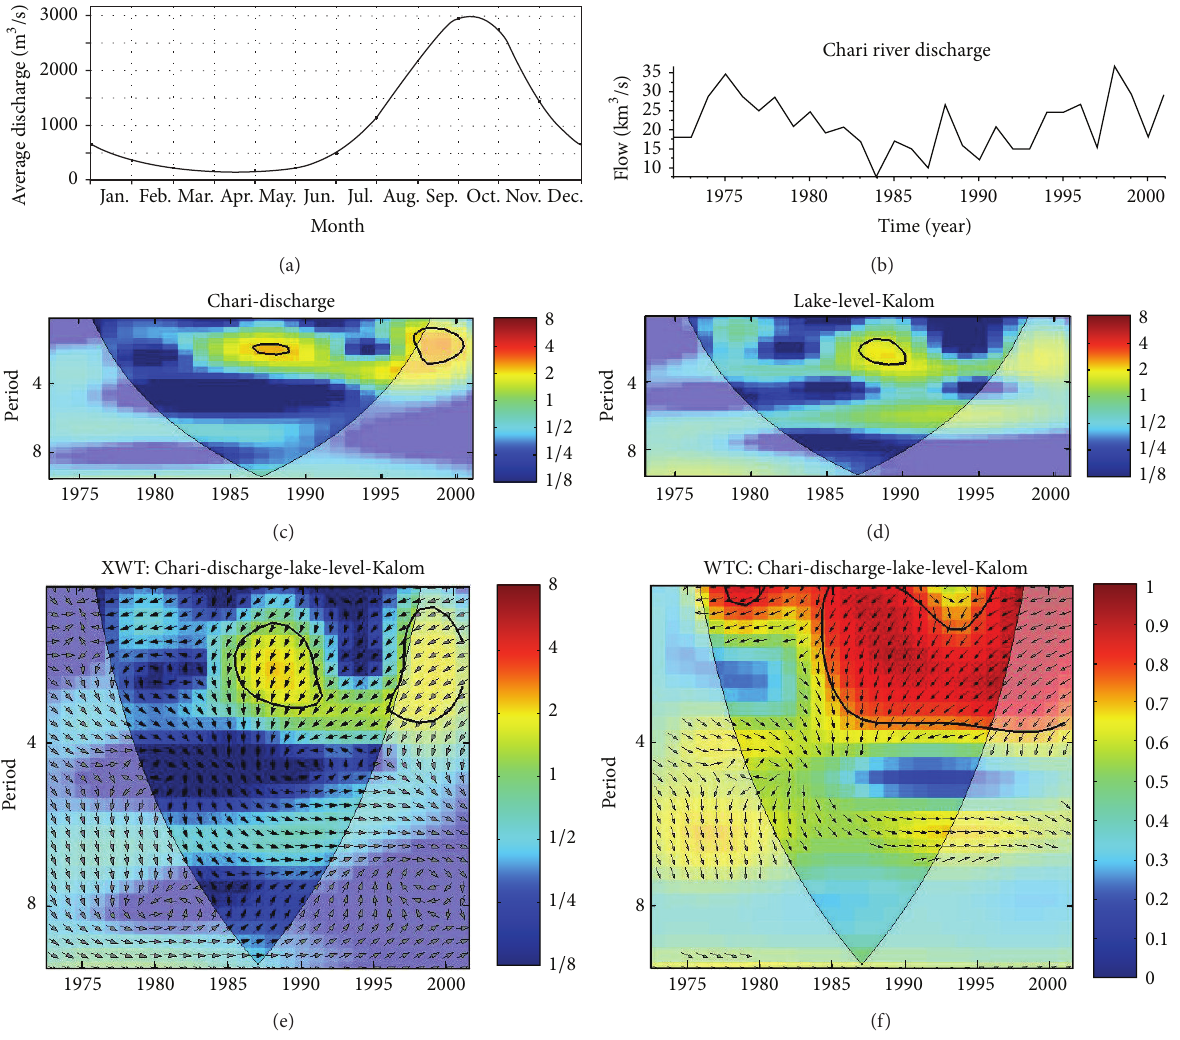
Figure 8: Chari River discharge: (a) mean monthly time series; (b) 1972–2000 time series; (c) CWT of Chari River discharge; (d) CWT of lake level at Kalom; (e) XWT; and (f) wavelet coherence. The thick contour enclosed regions are greater than 95% confidence for a red-noise process. The thin solid line indicates the “cone of influence,” where edge effects become